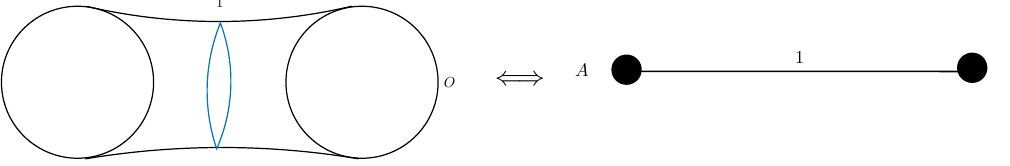
Figure 7 . A bulk geometry consisting of a wormhole between the two boundary regions A and O . This particular state is realized by a bulk metric which is AdS-Schwarzschild. The area of the minimal surface or throat is taken to have a value of one. This geometry can be viewed as a graph with a single edge connecting two boundary vertices A and O . The capacity of the edge is